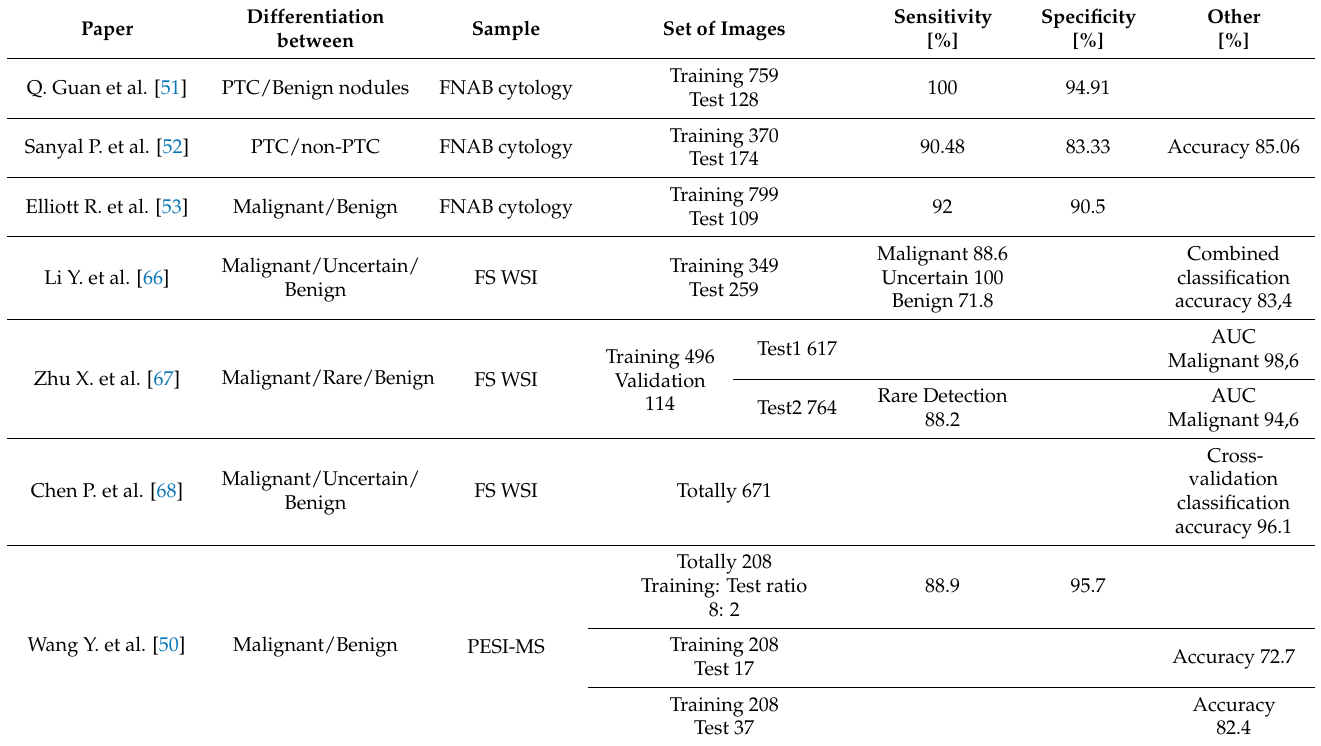
Table 3. A comparison of microscopic and mass spectroscopy methods in distinguishing the malig- nancy of the thyroid